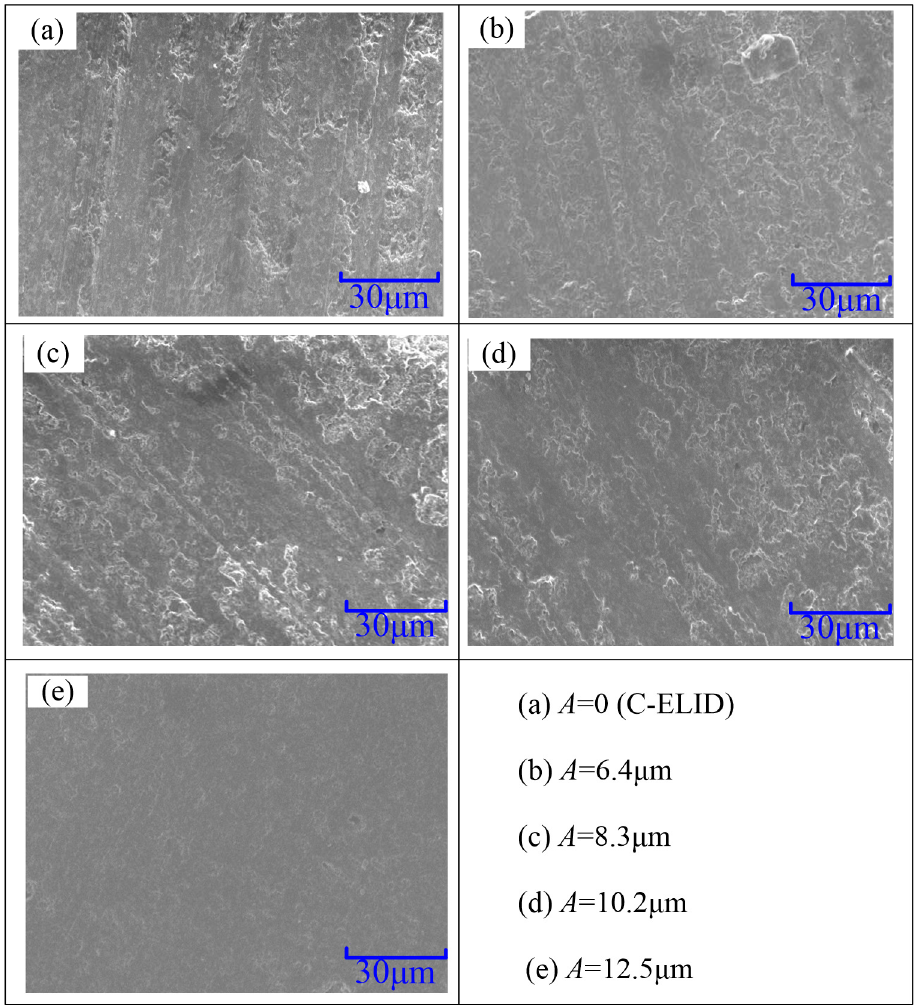
Figure 14. Surface morphology of the processed workpiece.